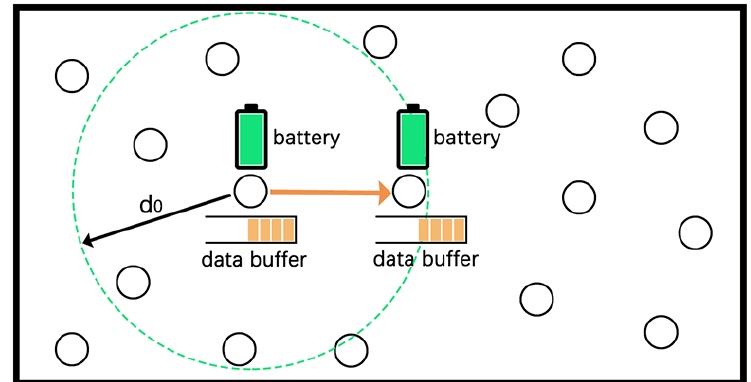
Figure 6. Reception state adjustment